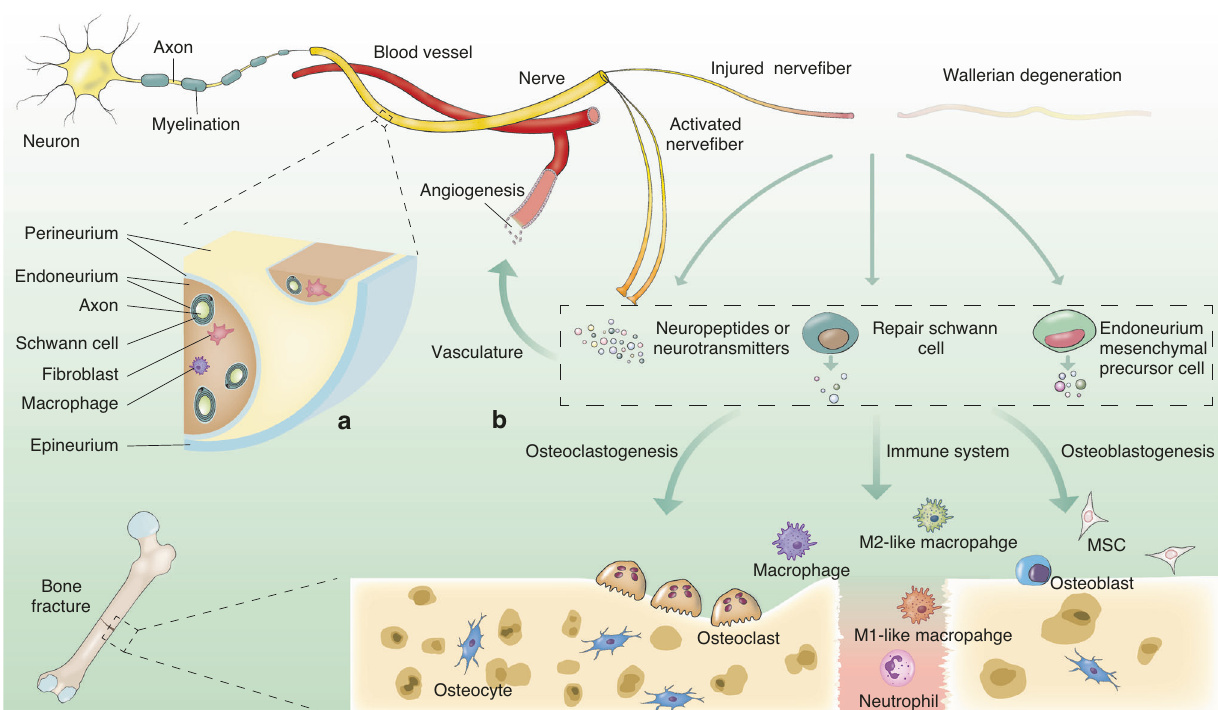
Fig. 3 Illustration of possible ways in which the PNS can regulate bone regeneration following trauma. a Structure of peripheral nerves and nerve-resident cells involved in bone regeneration. b The PNS regulates bone regeneration in two main ways: neuropeptides or neurotransmitters and nerve-resident cells. Neuropeptides or neurotransmitters can be secreted by injured and activated nerve fi bers. Nerve- resident cells, mainly SCs and endoneurial mesenchymal cells, alter their transcription and translation, changing their ordinary phenotype to a reparative one, which is similar to their precursor cells (these cells have a common origin from NCCs) after nerve injury. Repair SCs can secrete regulatory molecules, such as oncostatin M and PDGF-AA, to promote regeneration, and endoneurial mesenchymal cells in injured nerves differentiate into bone-lineage cells. The development of in fl ammation, the invasion of newly formed vessels, the differentiation of osteogenesis and osteoclastogenesis are all regulated by these responses of the PNS after bone patients who were treated with neurorrhaphy between the ilioinguinal nerve and the inferior alveolar nerve or auricular nerve during the reconstruction of the mandibular bone exhibited reduced bone absorption. 140 These clinical observations indicate the involvement of peripheral nerves in regulating osteogenesis from the embryonic phase to adulthood. The discovery of relevant neuropeptides and their receptors in bone-lineage cells is a cornerstone of their crosstalk with the PNS (Table 1), but how are the regulatory signals transported from neurons to the bone? Although osteocytes, osteoblasts, osteo- clasts, and vascular endothelial cells are located in close proximity to free nerve endings, 98,141,142 the rarity of these direct connec- tions casts doubt on the hypothesis of synaptic connections, which has not yet been found. 141,143,144 It is uncertain whether the effects of PNS fi bers on bone regeneration occur in a direct or indirect manner or both. Currently, two main ways whereby the PNS regulates bone regeneration have been proposed, as shown in Fig. 3.